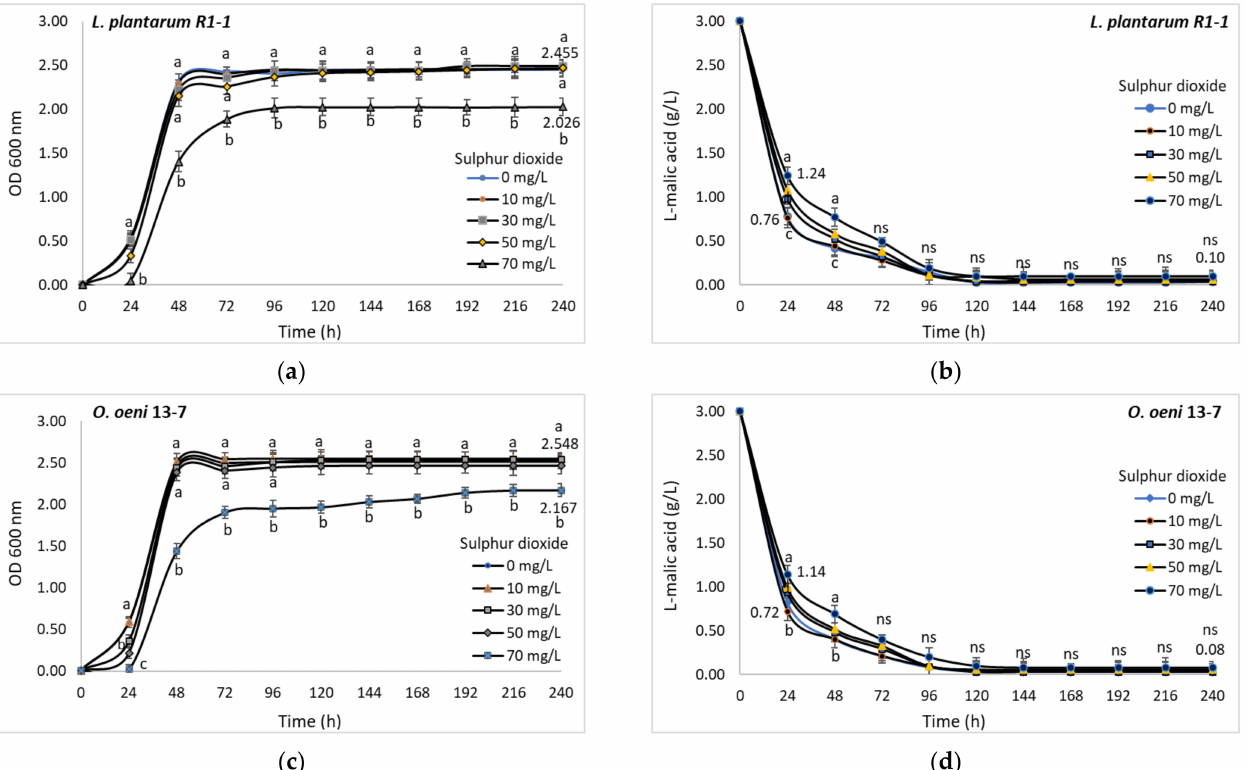
Figure 8. Influence of sulphur dioxide on cell development and malic acid metabolism of Lactobacillus plantarum strain R1-1 ( a , b ) and Oenococcus oeni strain 13-7 ( c , d ). Cells incubated in MRS-TJ broth (10 6 CFU/mL) at 28 ◦ C. Each value is the mean of a triplicate experiment, error bars indicate standard deviation ( ± ). In all cases the standard deviation was lower than 10% of the mean value. Different letters within the same column indicate significant differences between data ( p <